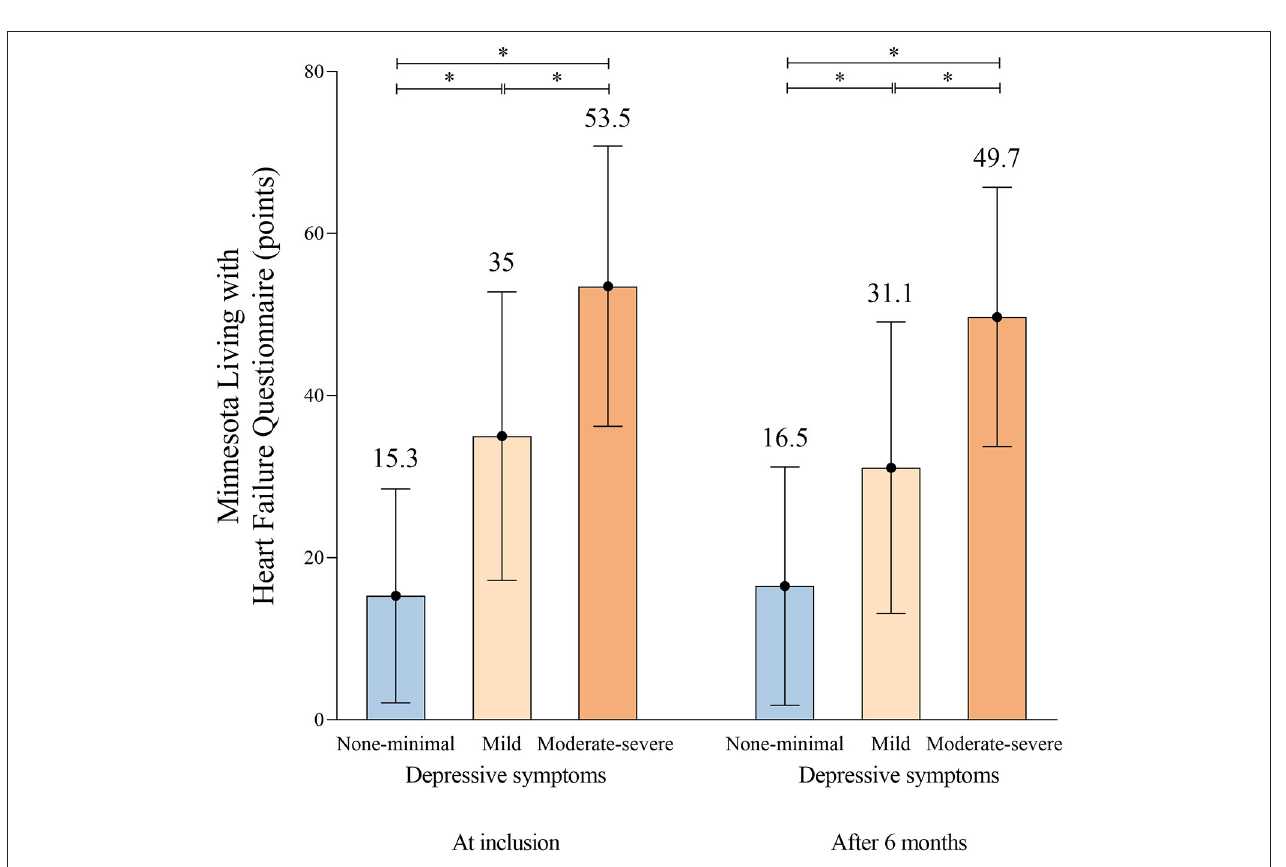
FIGURE 2 | Quality of life (mean value of the Minnesota Living with Heart Failure points) according to the grade of depressive symptoms at time of inclusion and after 6 months. * p <